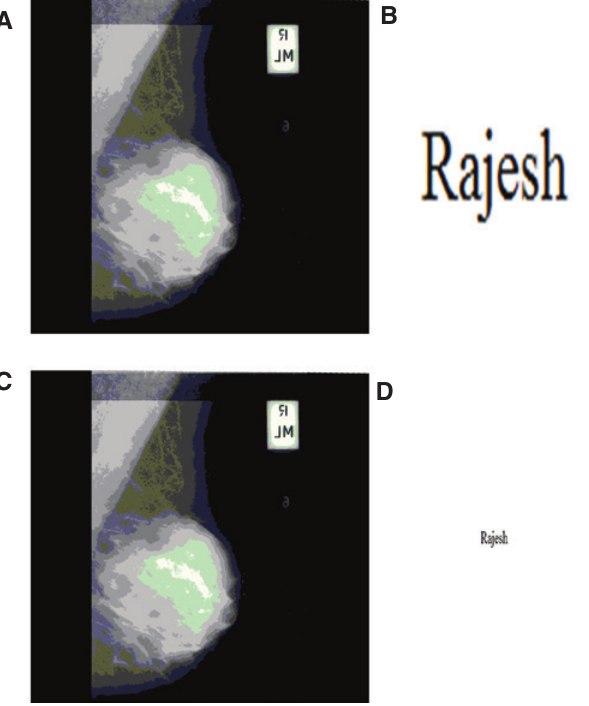
Figure 6: Intermediate Results of Image 4.